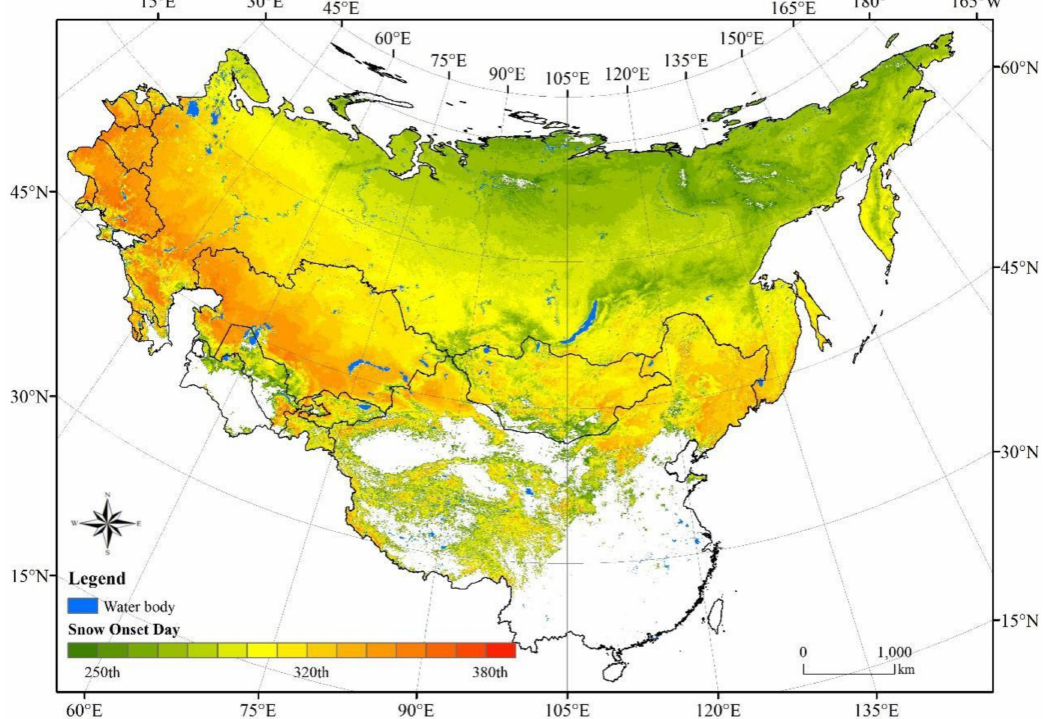
Figure 10. The spatial distribution of the annual mean cover onset day (SOD) in the study area from 2000 to 2016. (Note: SPi > 365 accounts for SOD in the next year, e.g., 370th for January 5 in the next